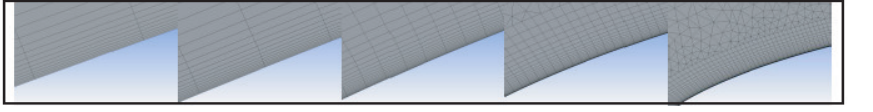
Figure 7. Close-up view of inflation layer at airfoil